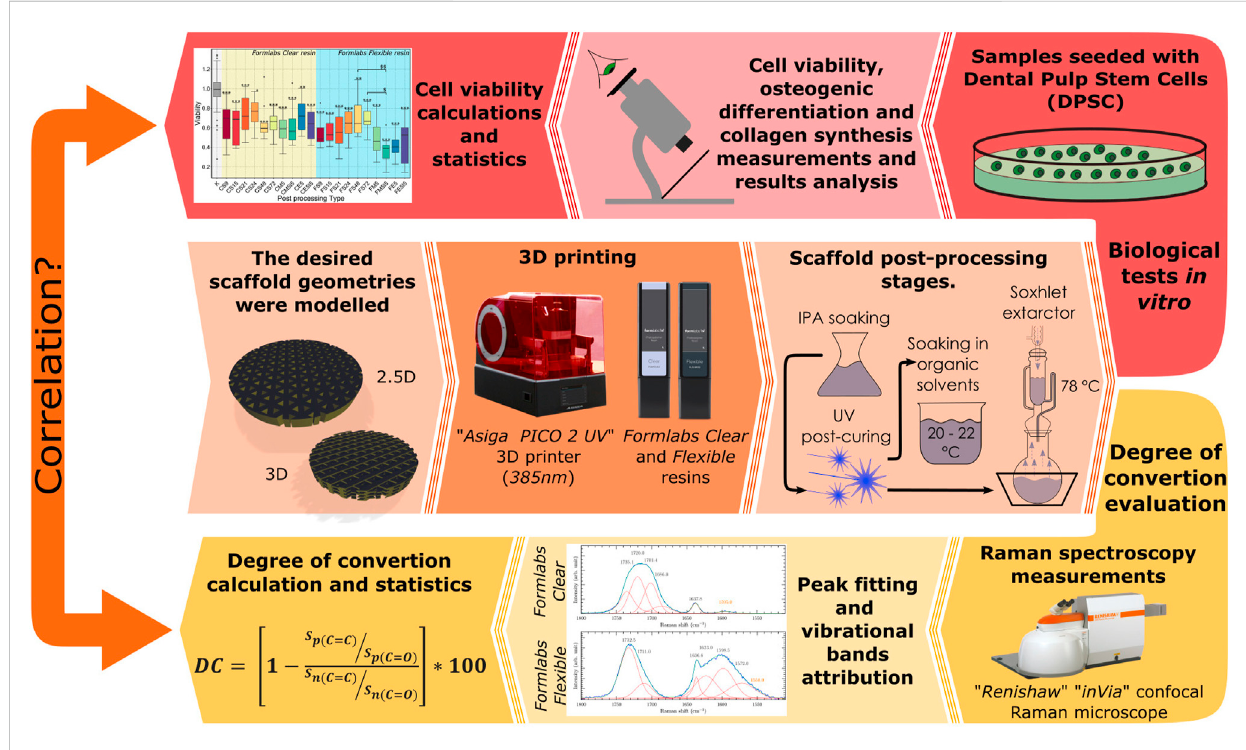
FIGURE 1 Graphical abstract of the entire study procedure representing framework geometries, material evaluated and polymerization device, post- processing methods and test types.